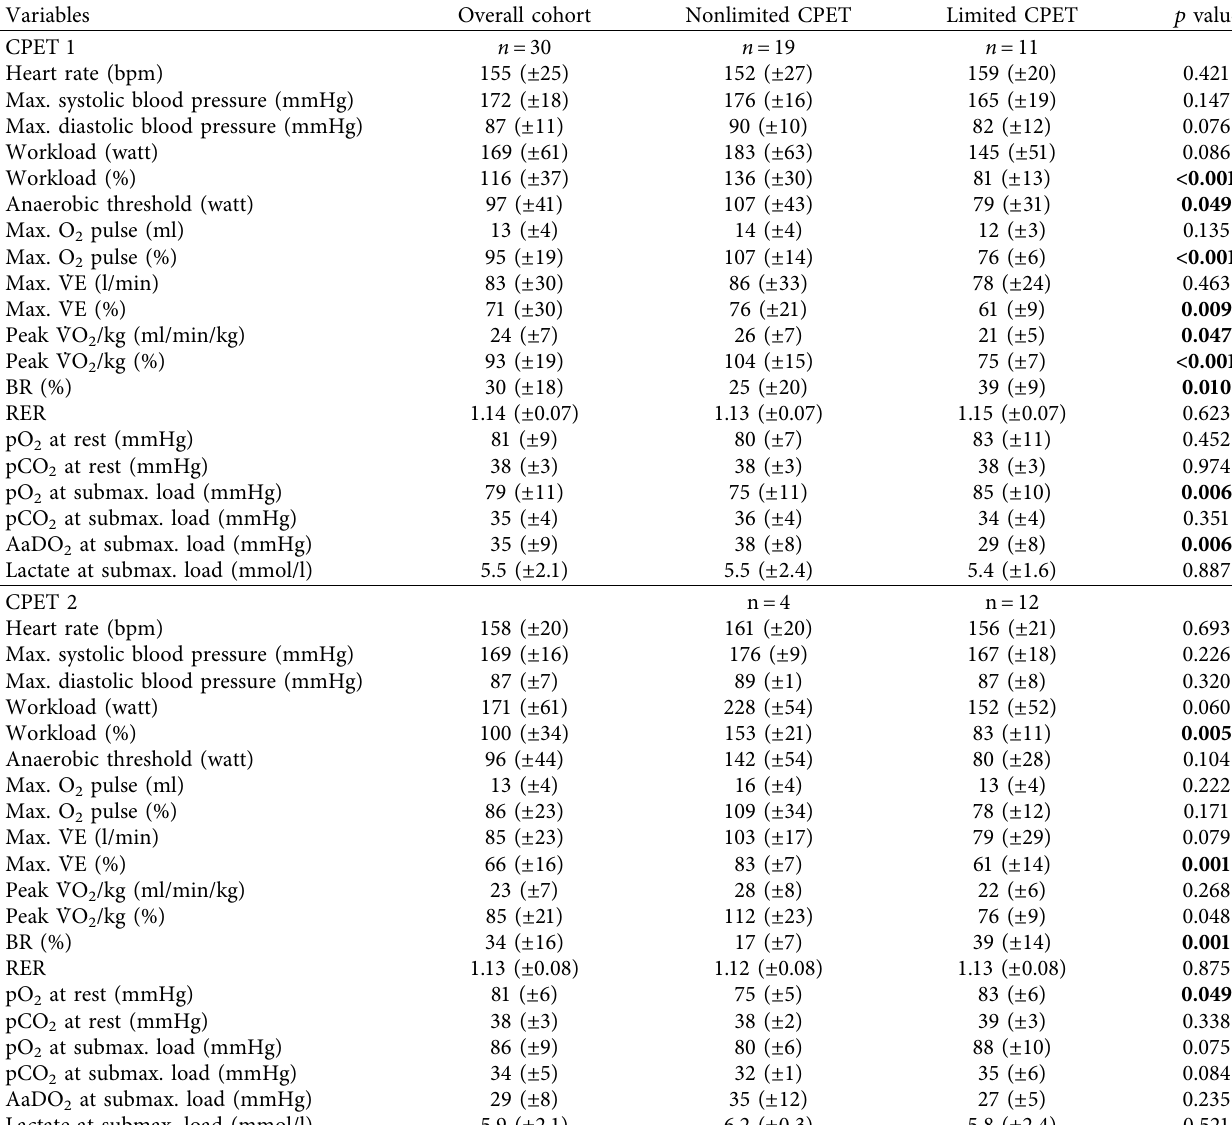
Table 3: Comparators of CPET1 and CPET2